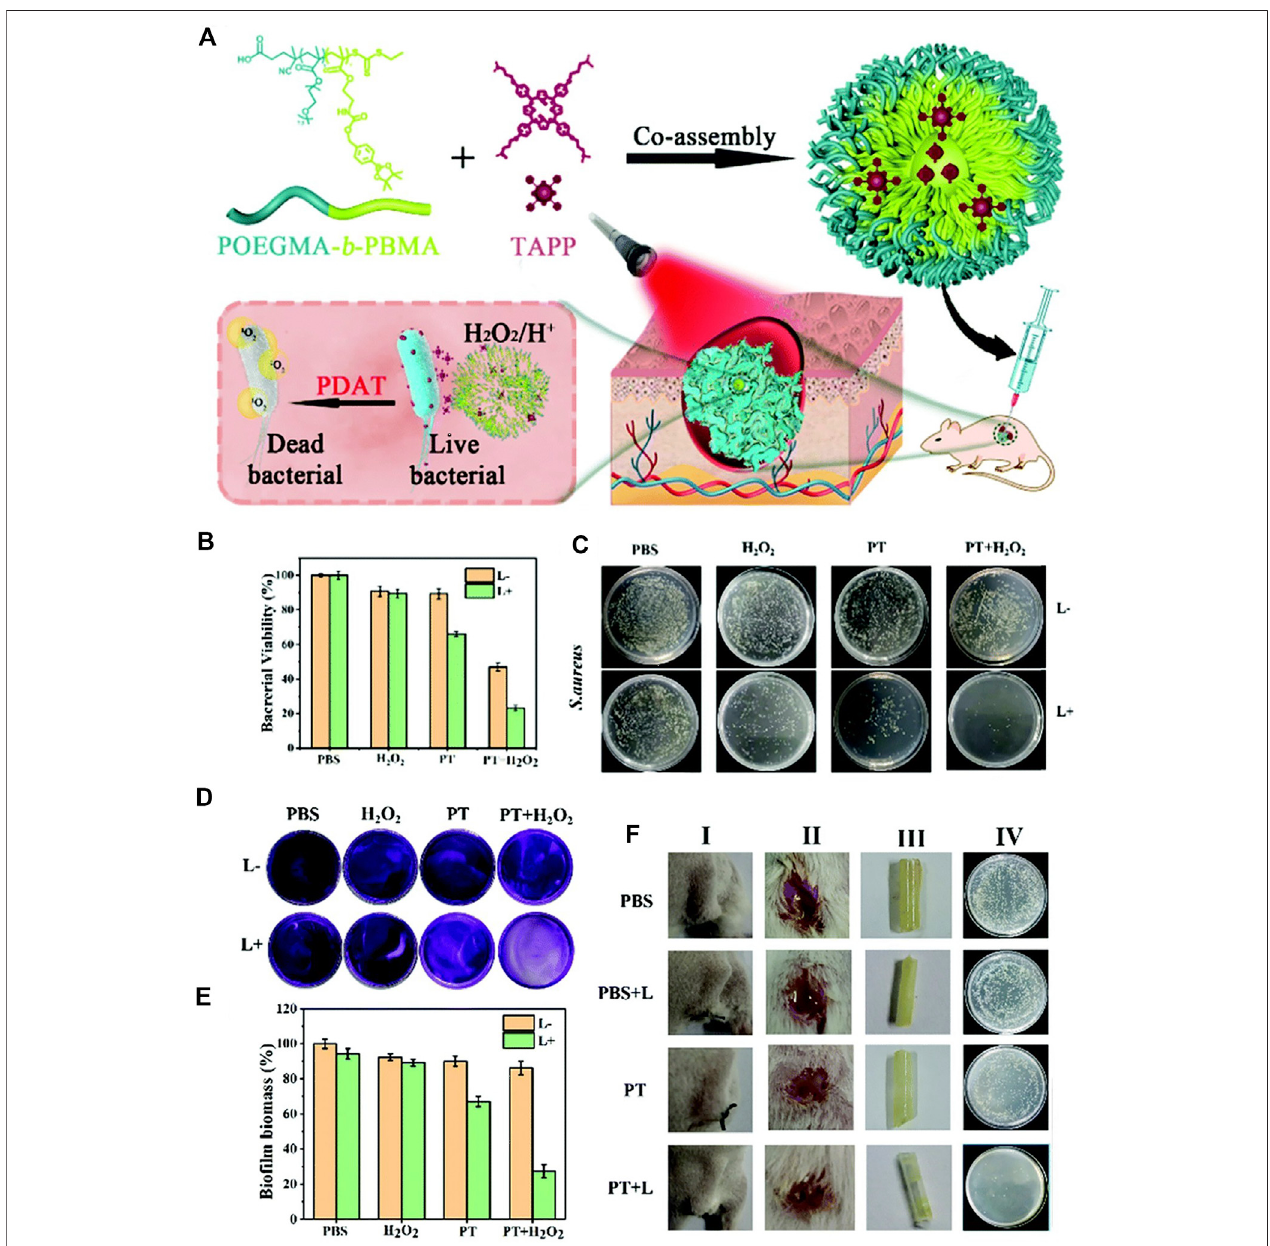
FIGURE15|(A) SchematicdiagramofapH/H 2 O 2 dual-responsivenanoplatformanditsphotodynamicantimicrobialtherapyprocess; (B) bacterialviabilityof S.aureus treated with different conditions at pH (cid:1) 5.5; (C) the corresponding S. aureus on agar plates after different treatments. Reprinted with permission from Zhao et al. (2021).